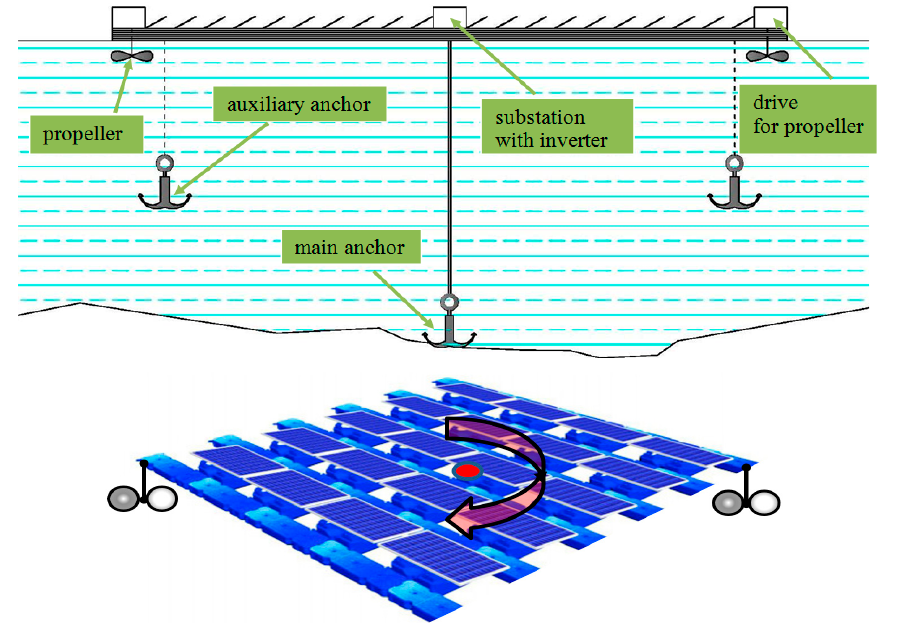
Figure 4. The conceptual design of the platform structure enabling the tracking of the Sun azimuth.